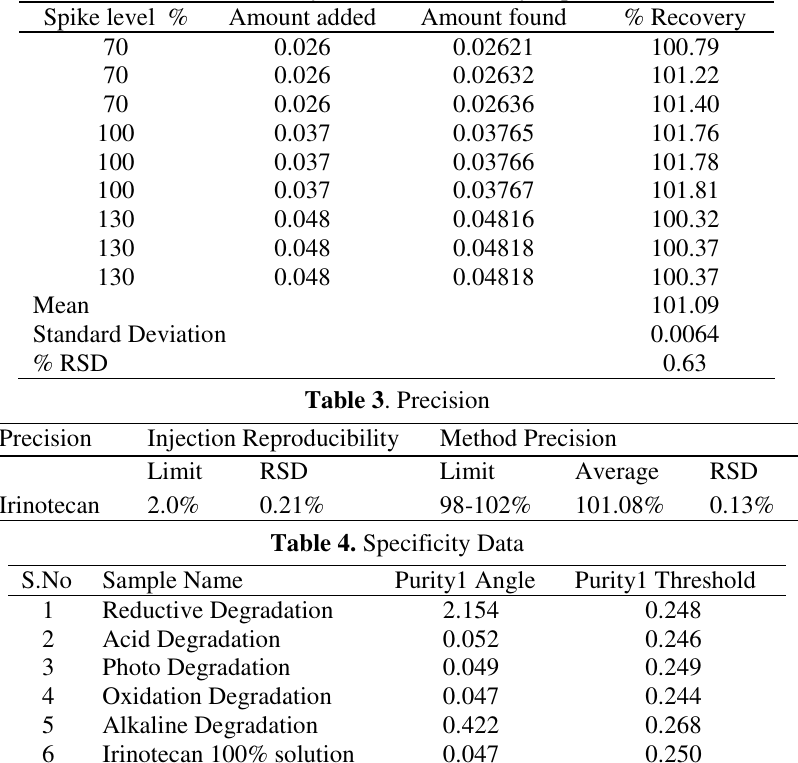
Figure 2 : Chromatograms of Irinotecan (left to right) extracted from formulation (40 µg/ml) and standard solution (40 µg/ml) Table 2 . Accuracy- Results of recovery experiments